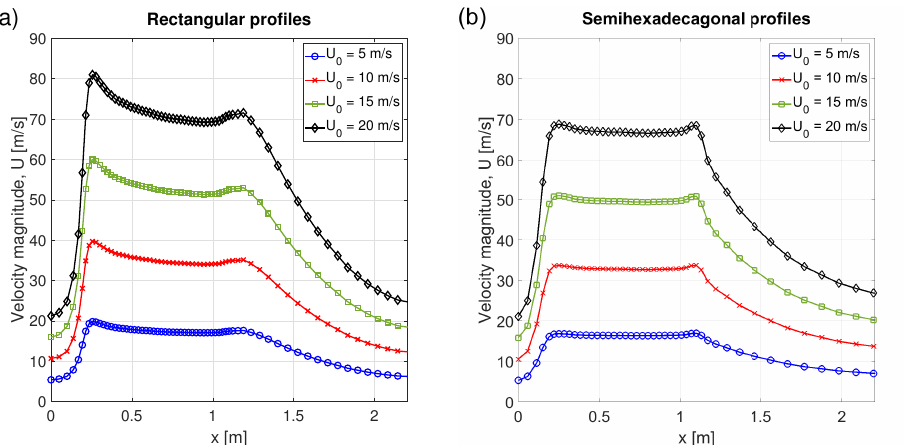
Figure 6. Numerical result of the variation of the flow velocity along the duct as a function of the position and the input face velocity in splitter silencers with ( a ) rectangular and ( b ) semihexadecago- nal profiles.